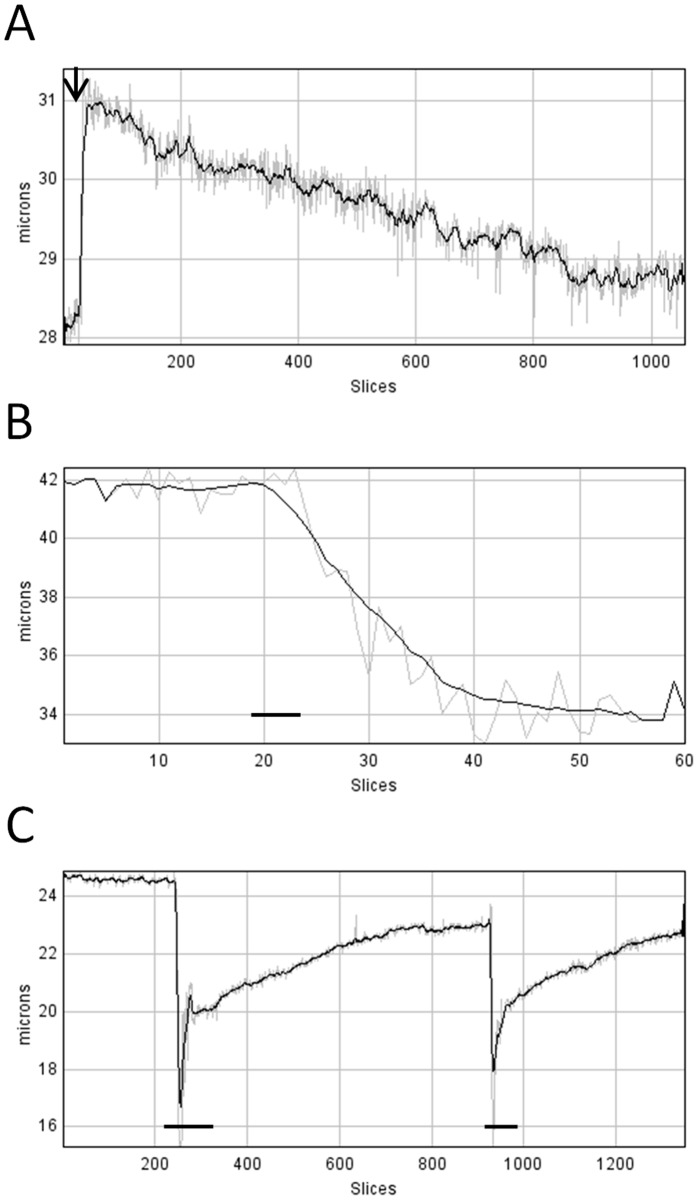
Diameter changes during vessel movements.A. Time course of dilation of a cannulated retinal arteriole to pressurisation from 0 to 40(indicated by a black arrow on top of the plot) followed by myogenic tone development over 7 minutes. The analysis was carried out using the preprocessing parameter to facilitate detection of the vessel walls and inclination correction to avoid introducing errors in the measurement of the diameters caused by the inclination of the vessel (see Manual of the software, File S1). B. Time course of constriction of a retinal arteriole to application of endothelin-1 (10 nM, horizontal black line). C. Time course of fast constrictions and slow dilations of a retinal arteriole caused by successive applications of caffeine (10 mM, horizontal black lines) over a period of ∼10 minutes. In all plots, a running average (black line) with a bin of 11 slices was superimposed on top of the raw diameters (grey line), as described in the software’s manual (File S1).